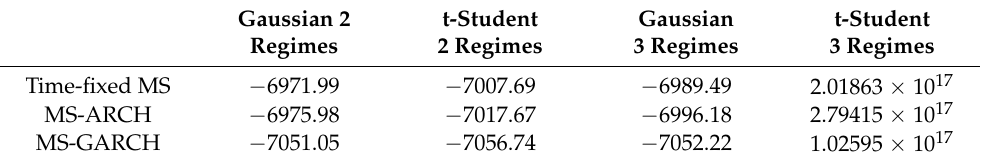
Table 3. The eight types of portfolios simulated, given the number of regimes fitted for each scenario and their corresponding security to invest, given the likelihood of being in each regime on the simulated